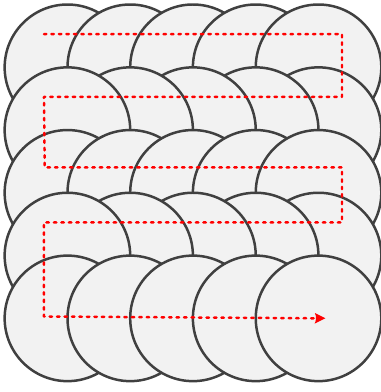
Fig. 2 | Track paths’ schematic of